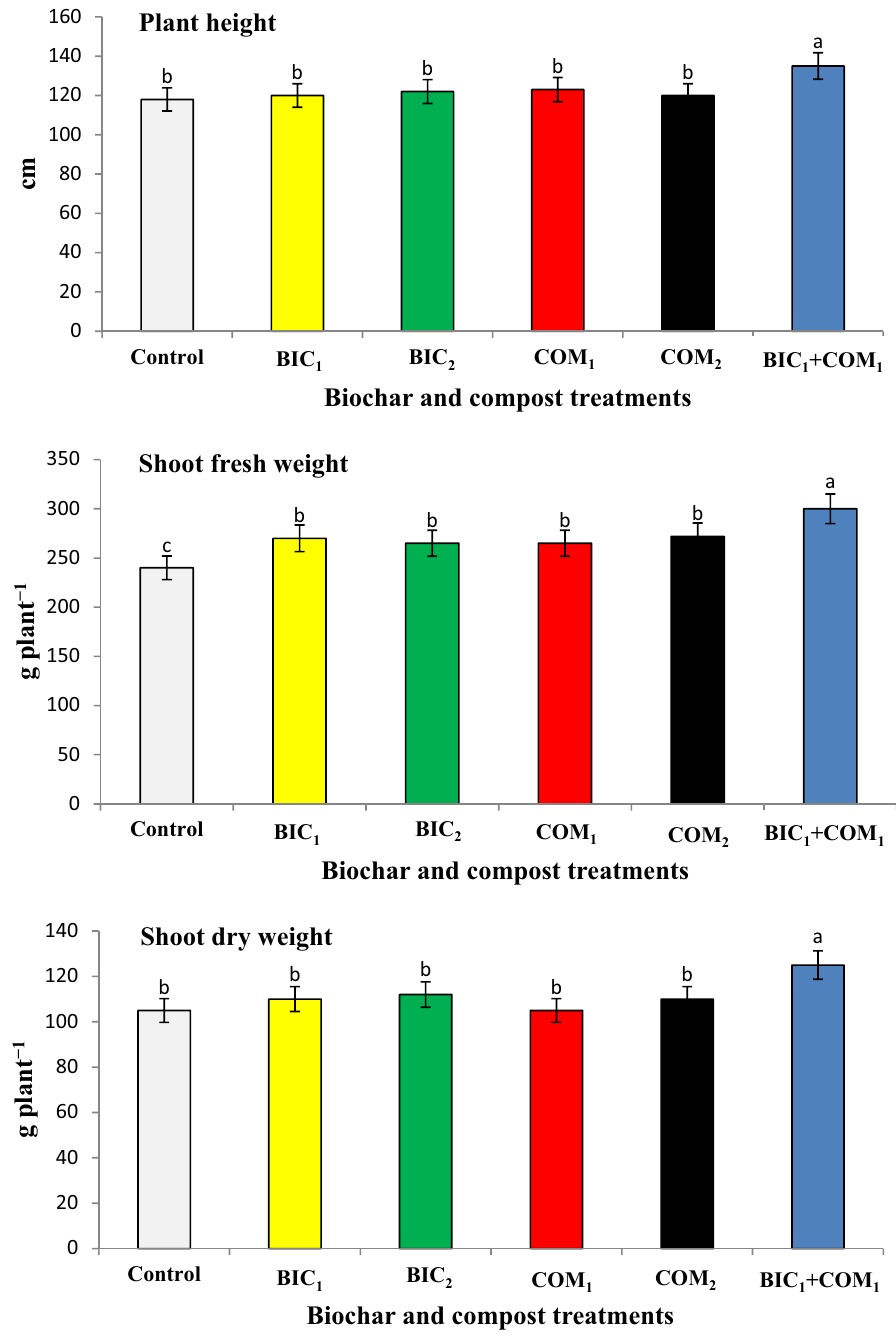
Figure 3. Effect of biochar and compost on some growth parameters of roselle plants. BIC 1 and BIC 2 = biochar at rates of 1 and 2% (w/w), COM 1 and COM 2 = compost at rates of 1 and 2% (w/w), and BIC 1 + COM 1 = mixture of the two amendments at 1% (w/w) of each. Means (± SD, n = 5) denoted by the same letter indicate no significant difference according to Tukey’s multiple range tests at p <